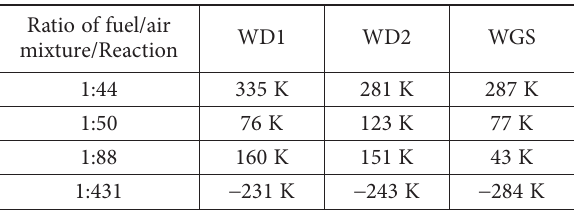
Table 5. Differences between theoretical and practical